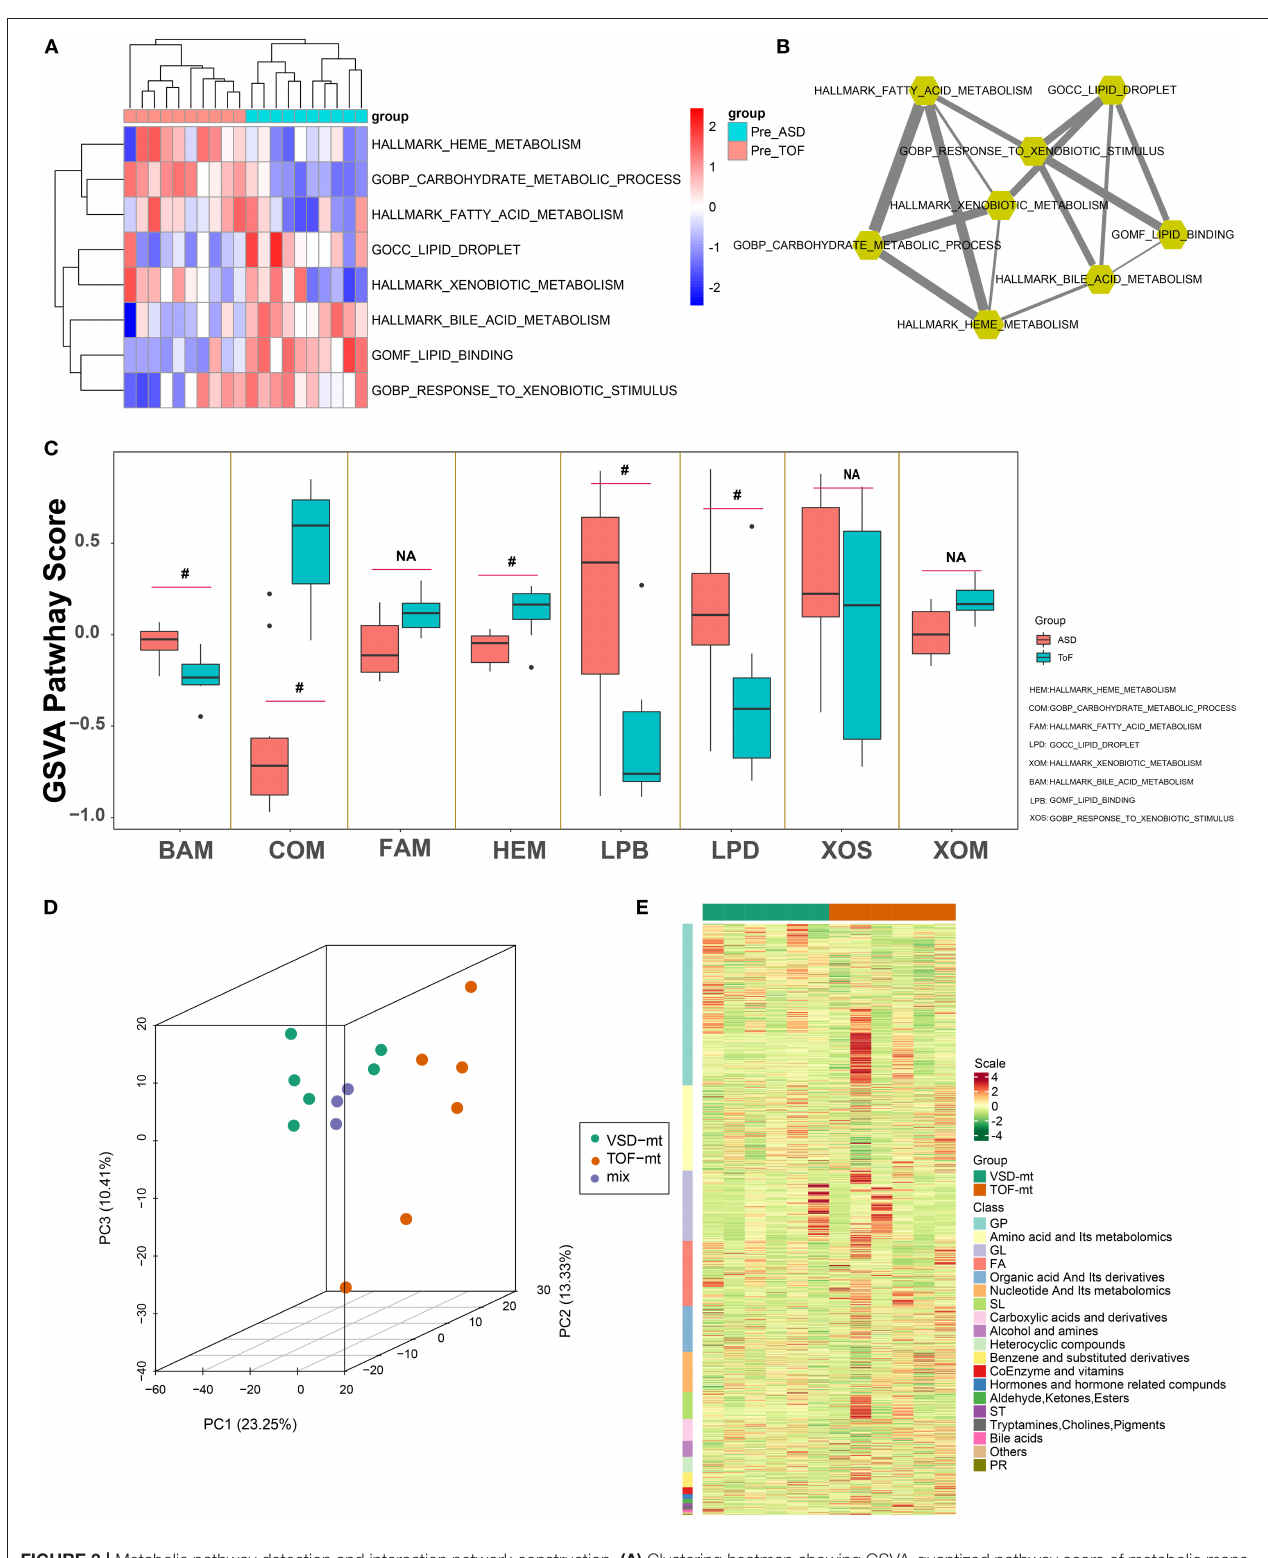
FIGURE 3 | Metabolic pathway detection and interaction network construction. (A) Clustering heatmap showing GSVA-quantized pathway score of metabolic maps. (B) Metabolic map interaction analysis was identified via weighted partial correlation analysis. (C) Differential analysis of metabolic pathways of GSVA score in Figure 2C . (D) Three-dimensional principal component analysis, showing right atrial biopsy sample distribution of ToF and ASD patients before cardiopulmonary bypass. (E) Clustering heatmap depicting the standard quantification of metabolites in ToF and ASD RA specimens. # p < 0.05.